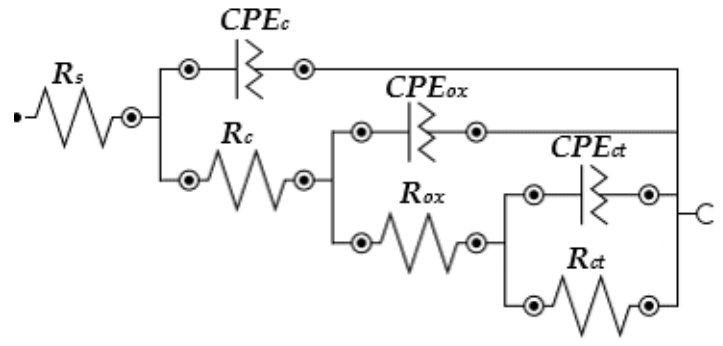
Figure 10. Schematic of EEC for the coatings